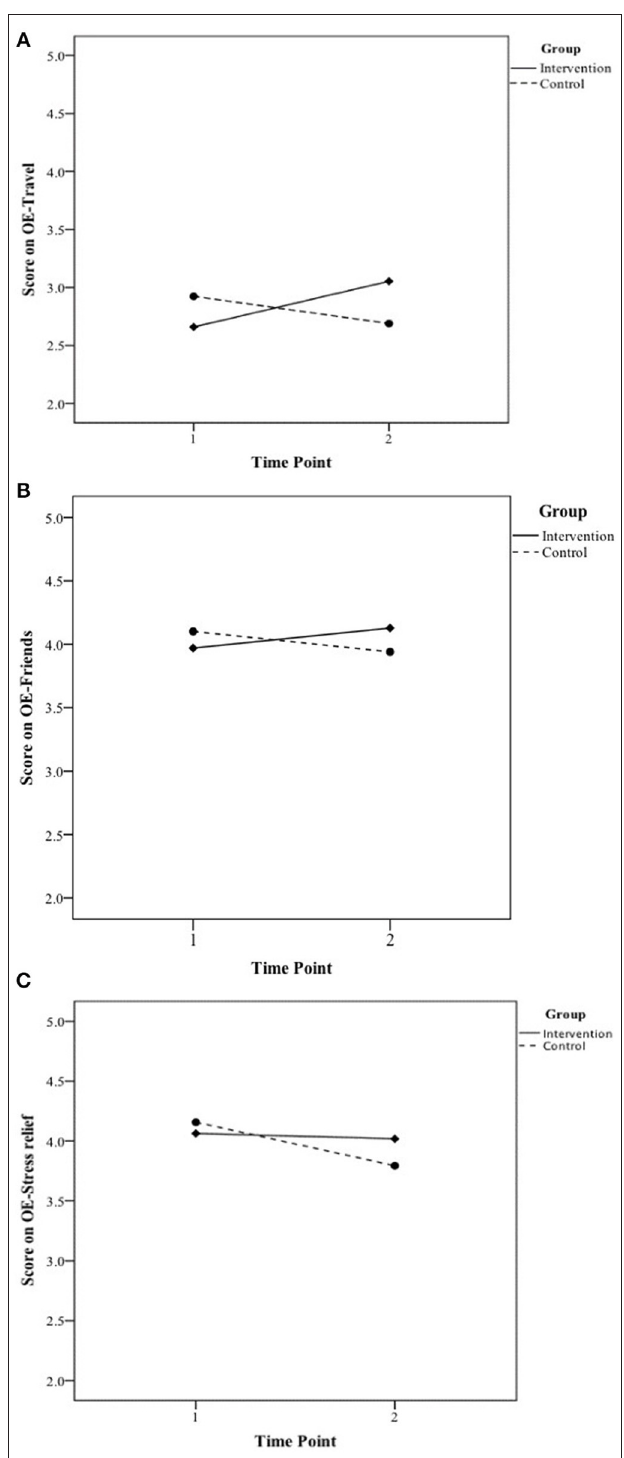
FIGURE 1 | Results for significant group by time interactions found when comparing a collapsed Intervention group (comprising GFM-alone and GFM + SE) to the Control group. (A) Represents expectancies to experience opportunities to travel, (B) Represents expectancies to have opportunities to be with friends, and (C) Represents expectancies to relieve stress via regular adult sport